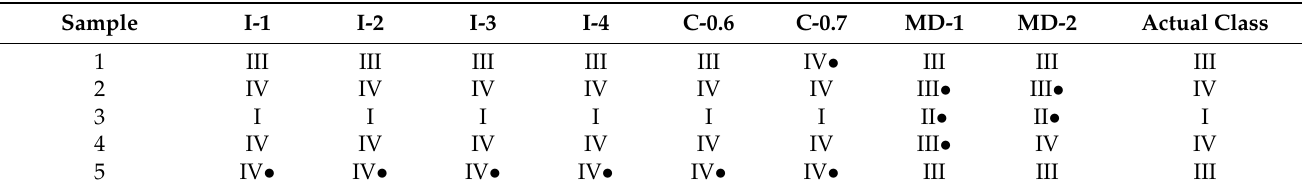
Table 5. Statistics of the predicted results of the case